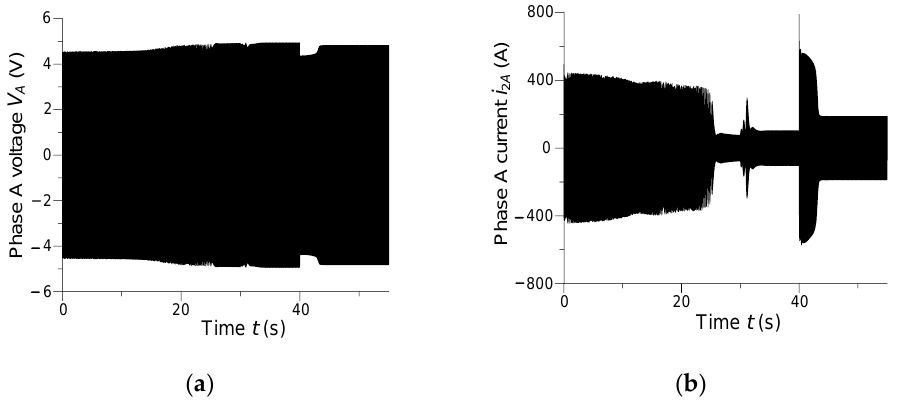
Figure 15. Instantaneous waveforms of: ( a ) phase A voltage of the drive system; and ( b ) phase A current in the secondary power transformer wiring.